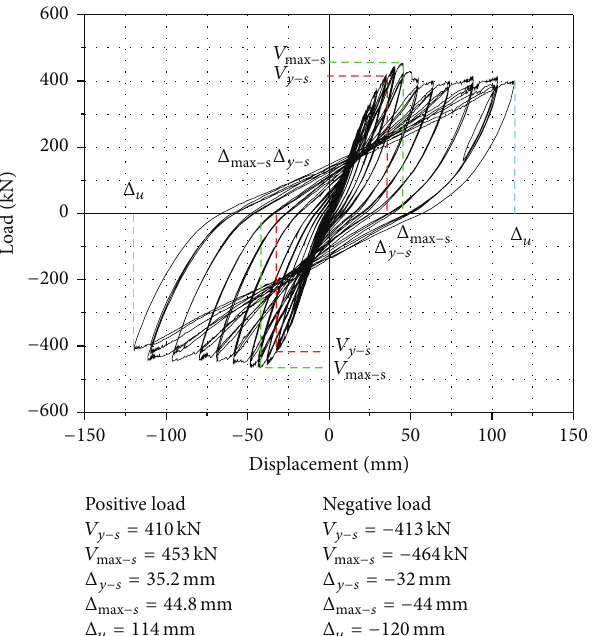
Figure 12: Lateral load-displacement curve of the SF-R2